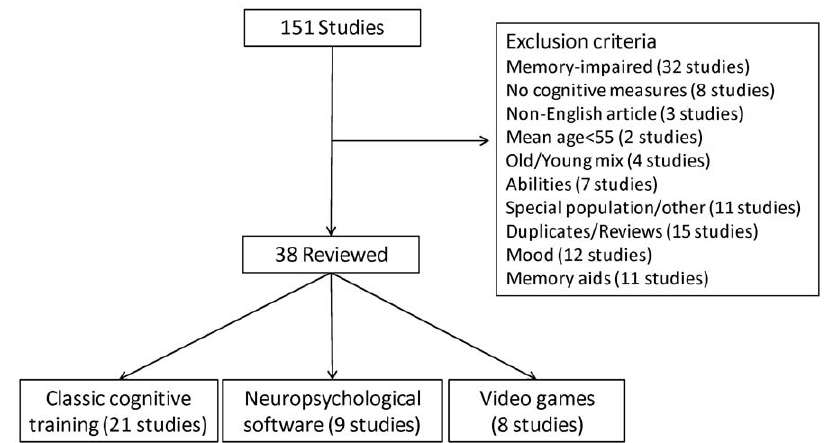
Figure 1. Identification of studies in the systematic review.